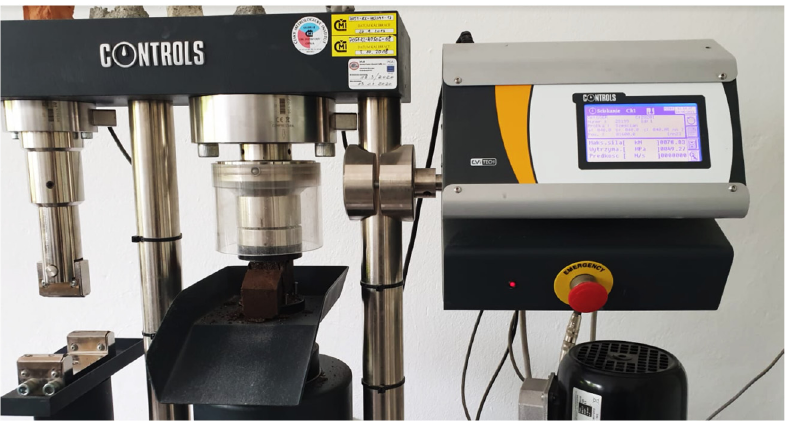
Figure 6. The view of the sample of geopolymer mortar under testing of the compressive strength.